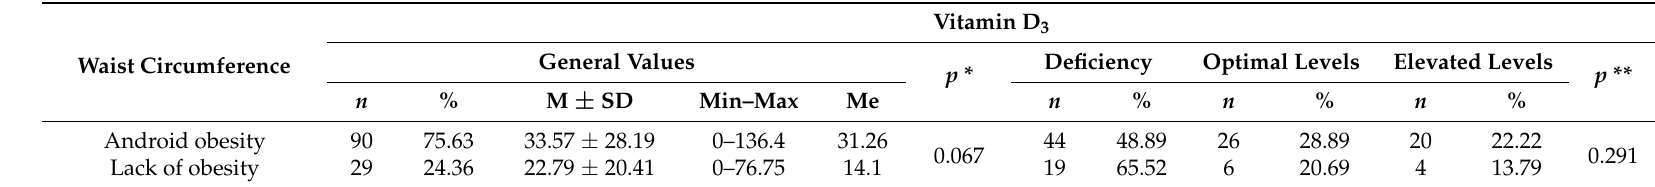
Table 2. Analysis of vitamin D 3 levels with regard to waist